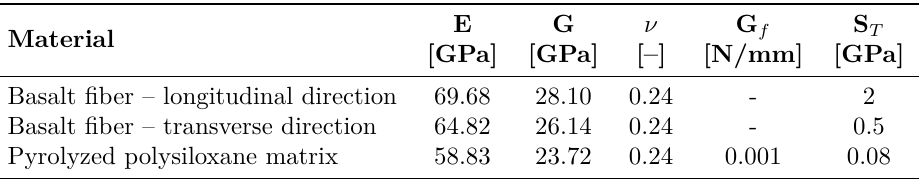
Table 2. Considered parameters of individual materials.